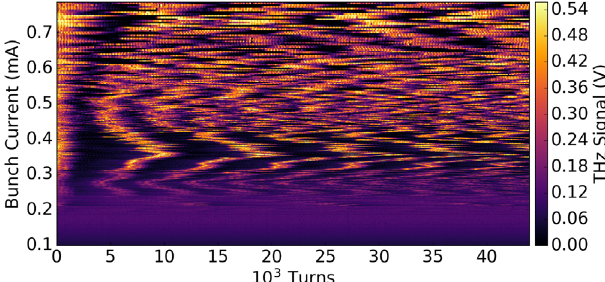
FIG. 2. THz signal (color coded) of one bunch as a function of turn number during the decrease of the bunch current. Both the temporal evolution and the repetition rate of an outburst show a strong dependence on bunch current. For better visibility the THz signals were shifted in time so that the first bursts are